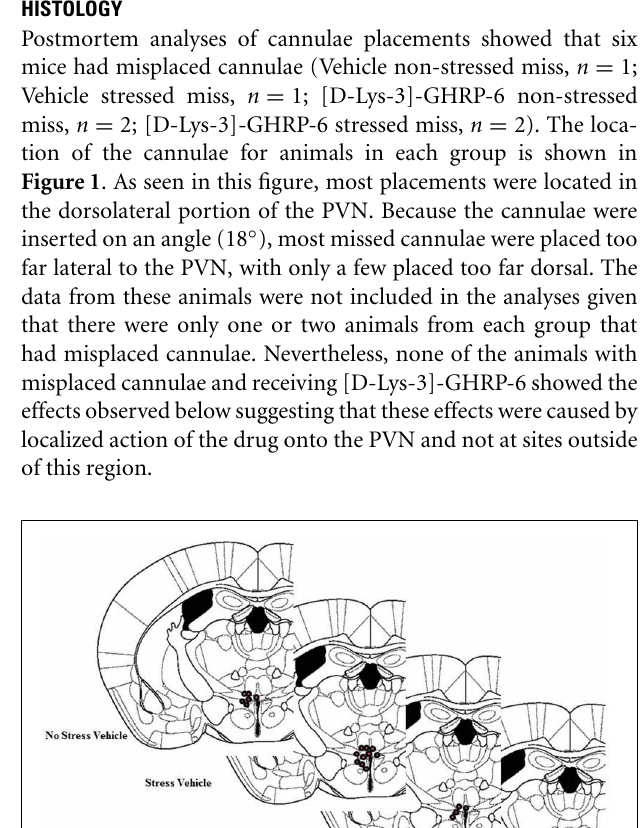
FIGURE 2 | (A) Average daily caloric intake (calculated as the sum of calories consumed from standard laboratory chow and high-fat diet), (B) average daily standard laboratory chow intake, (C) average number of calories consumed from the high fat diet per day for animals receiving either vehicle (0.9% saline) or 20nmol/day of [D-Lys3-]-GHRP-6; stressed and non-stressed animals are collapse to illustrate main effect of drug. All values are expressed as mean ± s.e.m. ∗ p < 0 . 05 relative to non-stressed controls. ψ p = 0 . 05 relative to vehicle treated